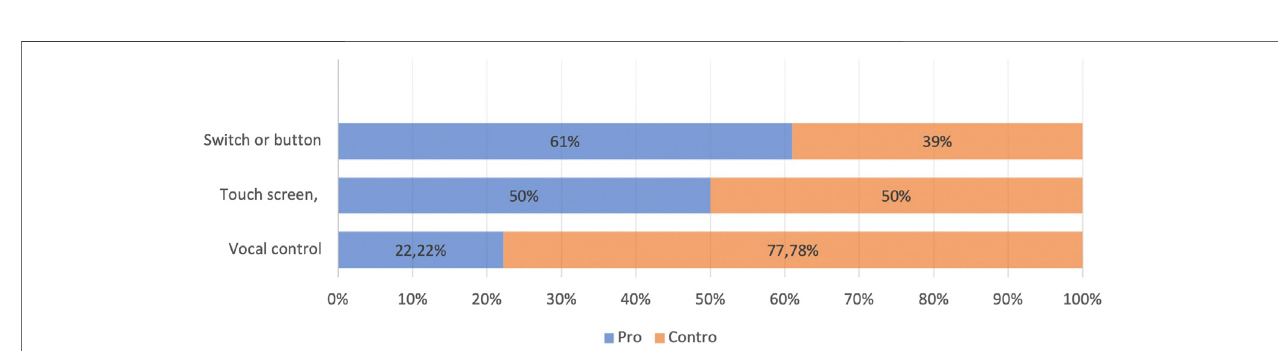
FIGURE 5 | Command mode preferences.